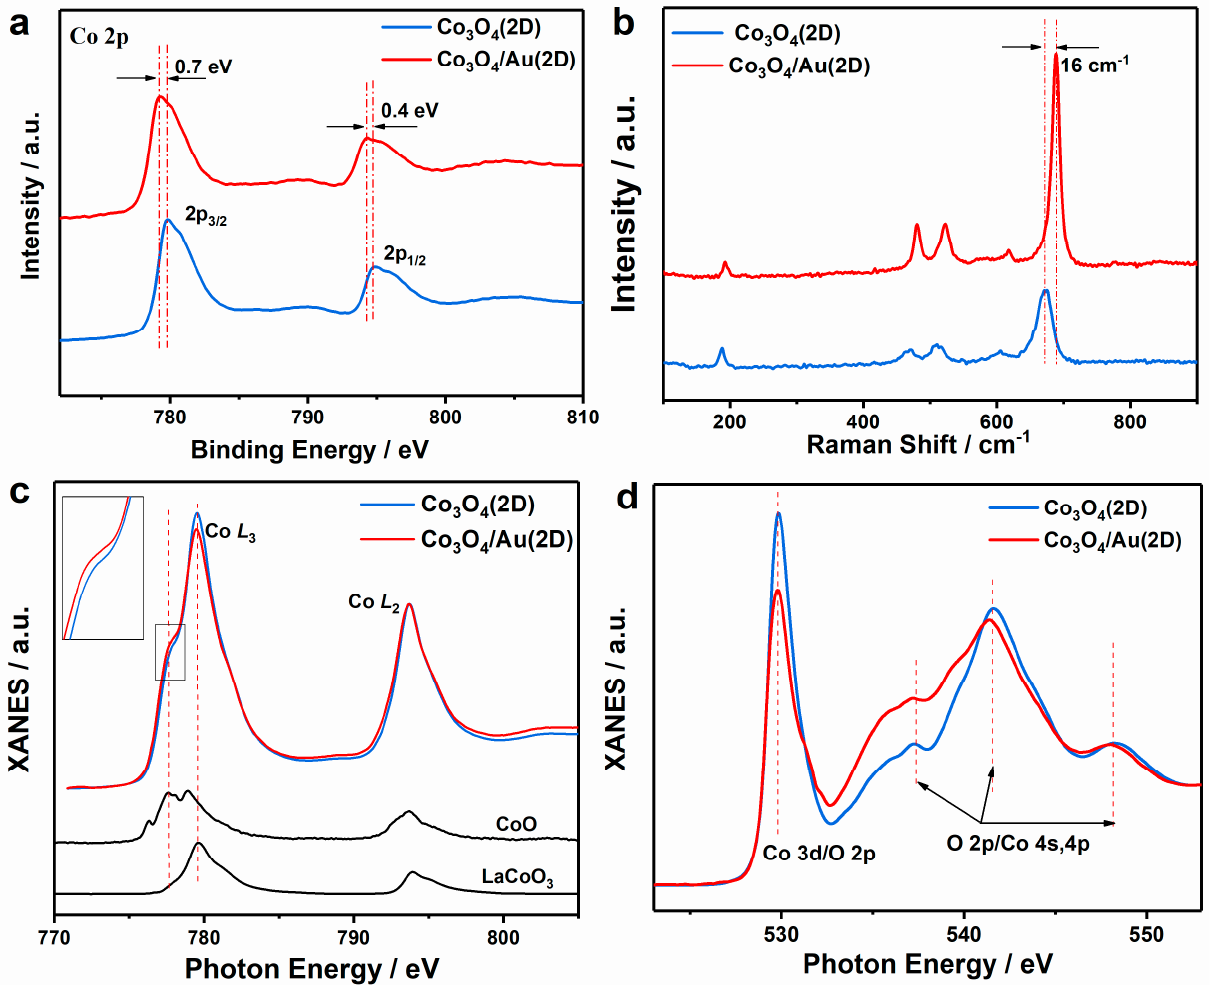
Figure 5. The electronical structure characterizations of Co 3 O 4 ultrathin nanosheets and Co 3 O 4 /Au nanocomposites: ( a ) XPS spectra of Co 2p level; ( b ) Raman spectra between 100 and 900 cm − 1 ; ( c ) XANES spectra of Co L-edge in Co 3 O 4 ultrathin nanosheets and Co 3 O 4 /Au nanocomposites, and XANES spectra of LaCoO 3 and CoO are cited from Ref [25]; and ( d ) XANES spectra of O K-edge in Co 3 O 4 ultrathin nanosheets and Co 3 O 4 /Au